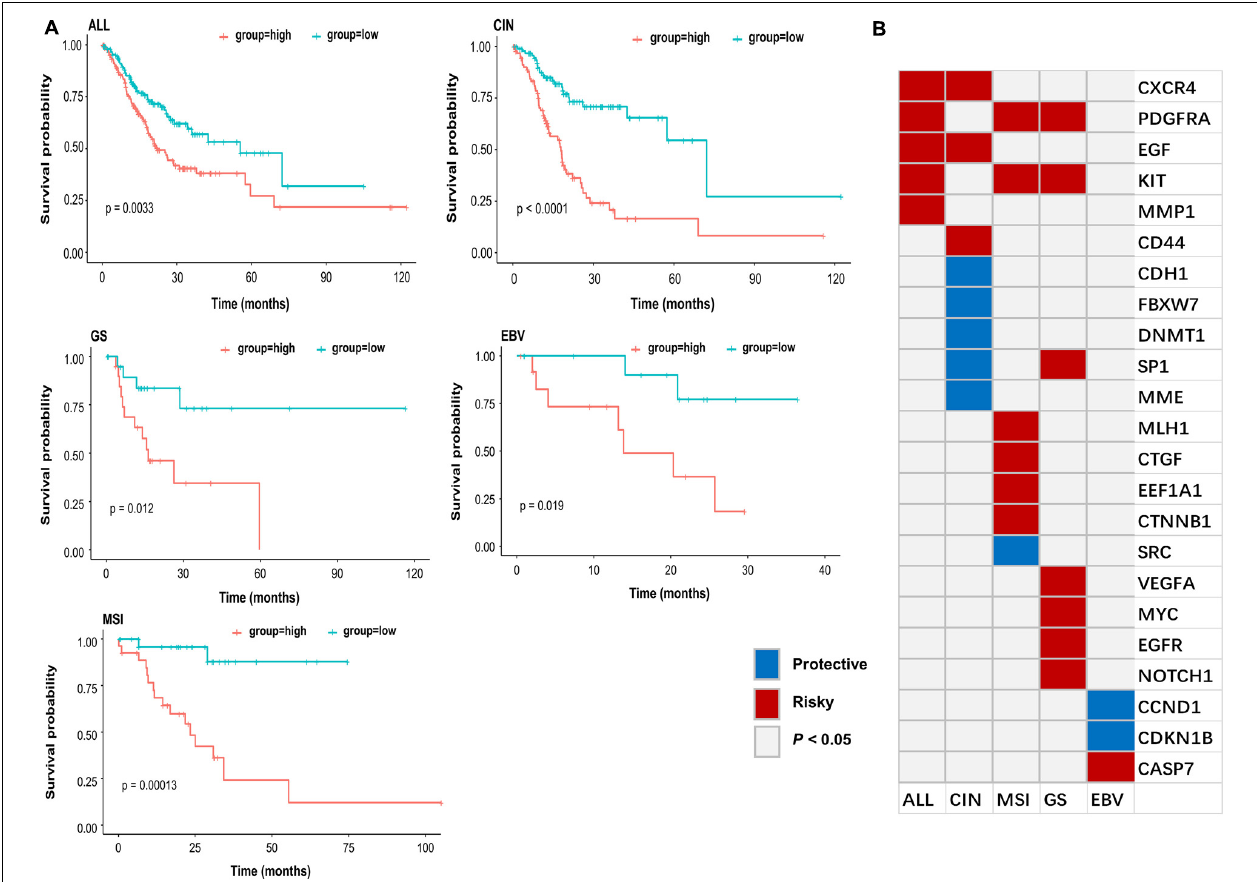
FIGURE 5 | Subtype-specific progression associated genes. (A) Kaplan-Meier estimates of overall survival rate for all samples (ALL), CIN, GS, EBV, and MSI subtype of TCGA patient cohort according to the expression pattern of subtype-specific genes in (B) . Red line indicated that GC patients with high-risk scores were associated with a lower median survival rate, and green line indicated that GC patients with low-risk scores were associated with a higher median survival rate. (B) Subtype specific gastric cancer progression associated genes ( P < 0.05 were shown). Red (Risky) indicated that higher gene expression associated with worse survival, and blue (Protective) indicated that higher gene expression associated with better